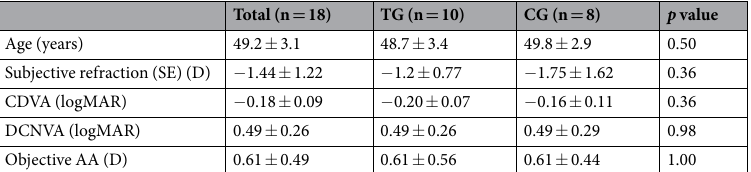
Total (n = 18) TG (n = 10) CG (n = 8) p value